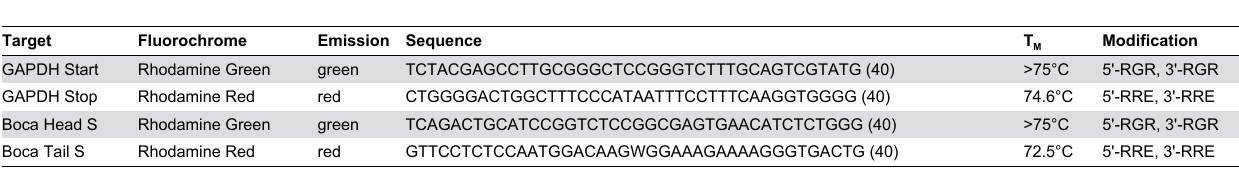
Table 1. FISH probes used for the detection of HBoV and GAPDH genes in FFPE slides of colorectal and lung tumors.